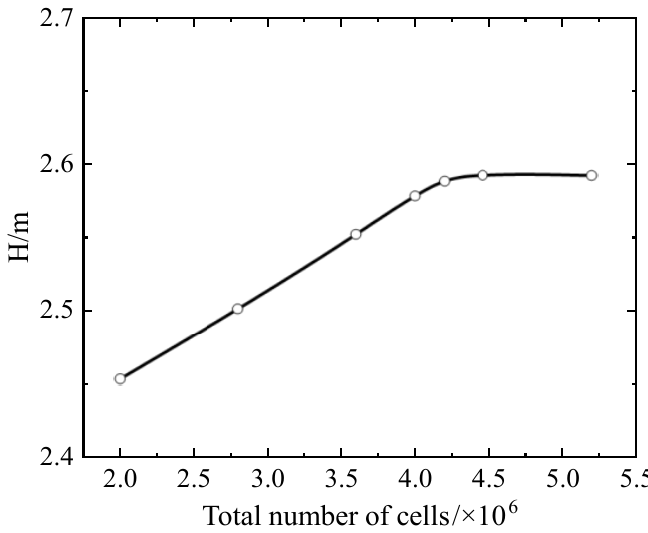
Figure 2. Grid independence verification.